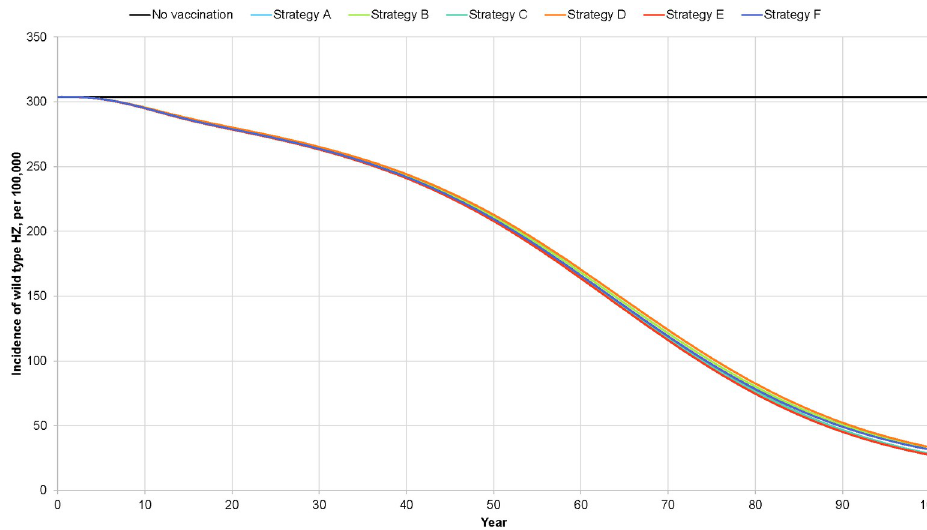
Fig 3. Projected impact of varicella vaccination on herpes zoster